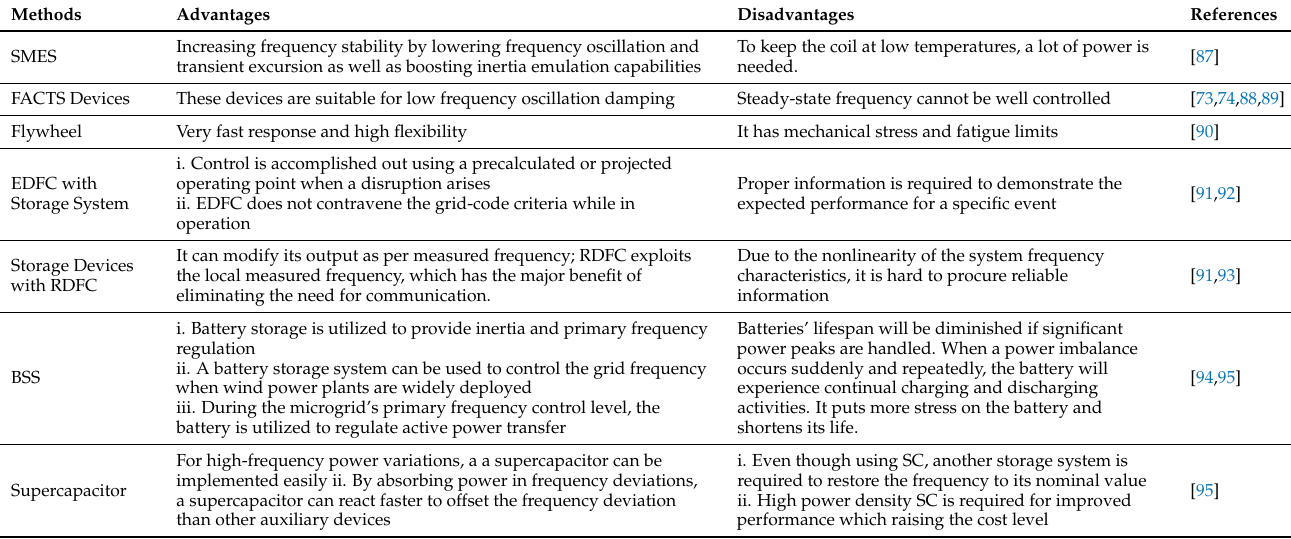
Table 2. Comparison of frequency control methods with auxiliary devices.